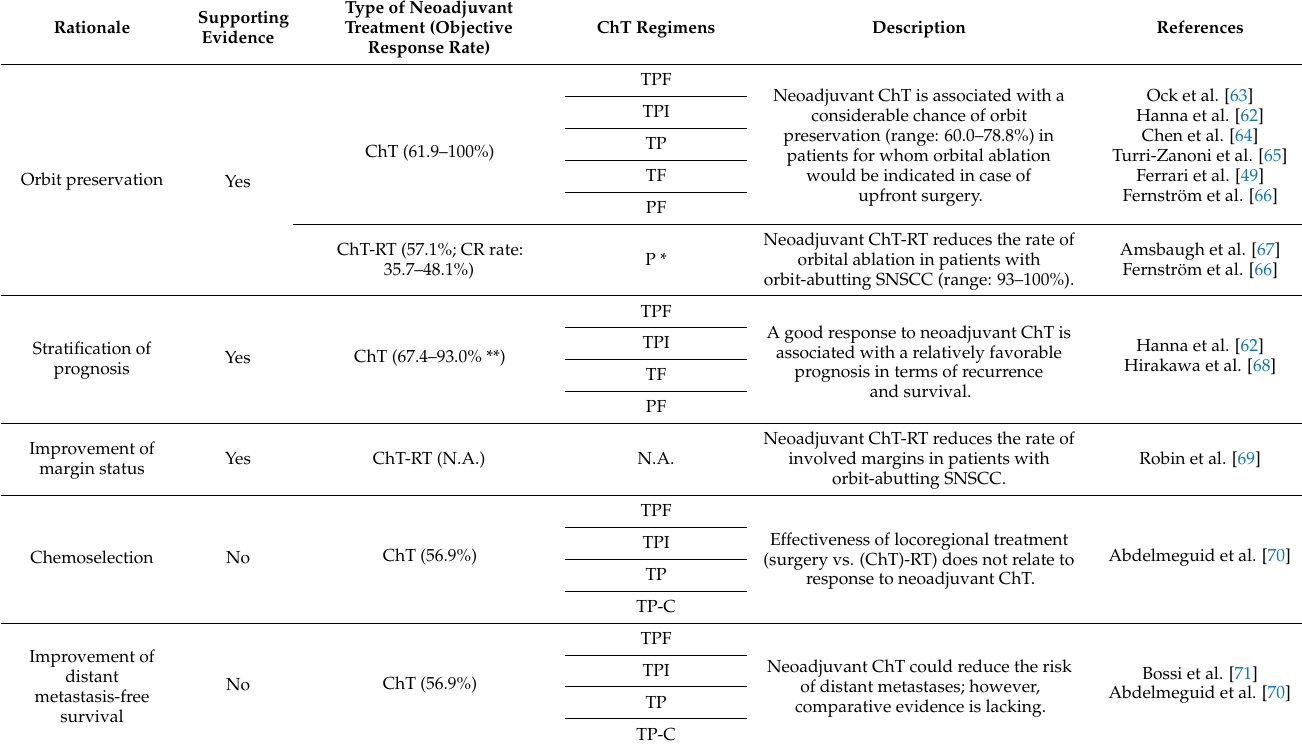
Table 1. Table summarizing the goals of neoadjuvant chemotherapy (ChT) and chemoradiation (ChT-RT) alongside supporting evidence. A, adriamycin; C, cetuximab; CR, complete response; E, etoposide; F, 5-fluorouracile; I, ifosfamide; N.A., not available; P, cisplatin; T, taxane. * Concurrent to RT; ** Hirawaka et al. [58] used different evaluation criteria to measure response to treatment, other authors used RECIST (Response Evaluation Criteria In Solid